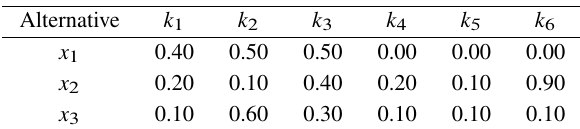
Table 7 Fuzzy soft set ( F , I